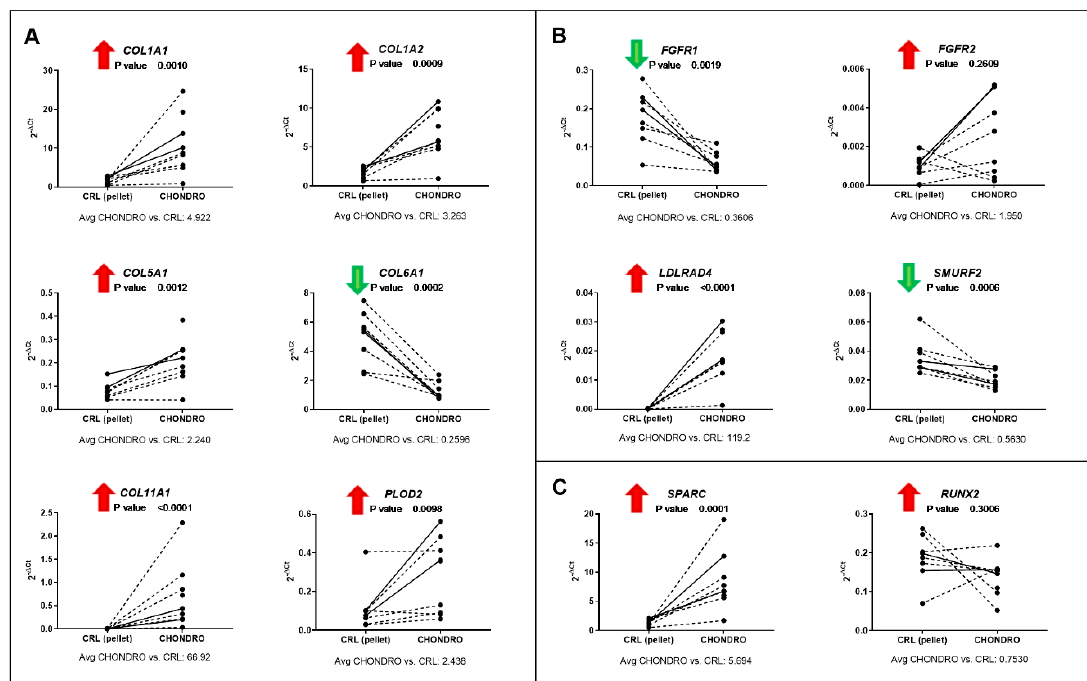
Figure 4. qPCR validation of linear targets corresponding to di ff erentially expressed circular RNAs in chondrogenic di ff erentiation and associated to ( A ) collagen fibril synthesis; ( B ) FGF and TGF- β signaling pathways; ( C ) endochondral ossification pathway. Full lines represent results from the same donors used for microarray, while dashed lines correspond to additional donors tested. For each gene of interest (GOI), the results are shown as 2 − ∆ Ct , where ∆ Ct is calculated as the di ff erence between GOI and reference gene ( RPLP0 ) Ct values. The p -value and the average fold change between day 7 chondrogenic di ff erentiation and day 7 control (pellet) expression are reported for each gene. The arrow next to the gene symbol indicates if the corresponding circRNA resulted as up- or downregulated from the microarray